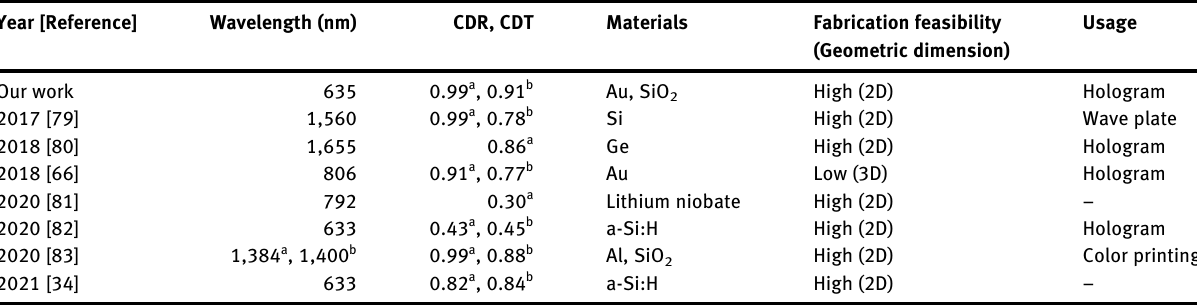
Table  : Comparison of chiral structural materials for PB-phase metasurfaces working at the near-infrared and visible frequencies. All CDR valueiscalculatedasanabsolutevalueof( R R − R L )/( R R + R L )forclearcomparison.Fortransmissivemetasurfaces,CDRsarereplacedbycircular dichroism on transmission (CDT) that is expressed as an absolute value of ( T R − T L )/( T R + T L ). Superscripts: CDR, CDT calculated by (a): simulation, (b):